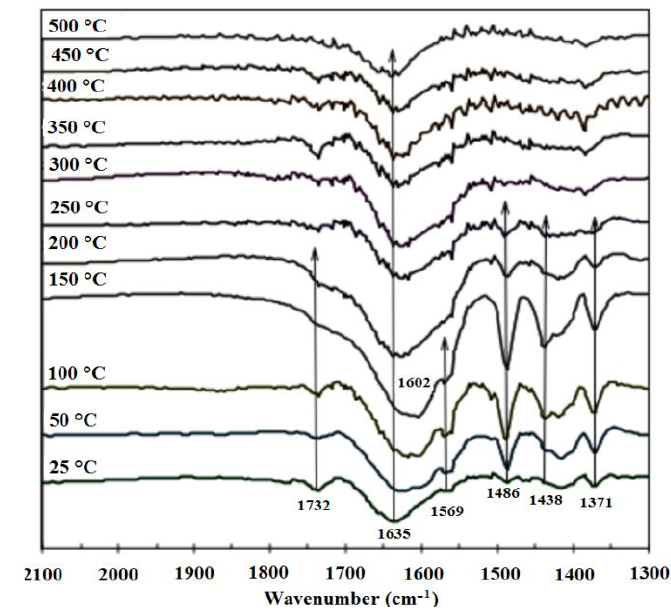
Figure 7. FT-IR spectra furfural desorption at different temperatures in the Pt-Fe/Al 0.5-0.5%